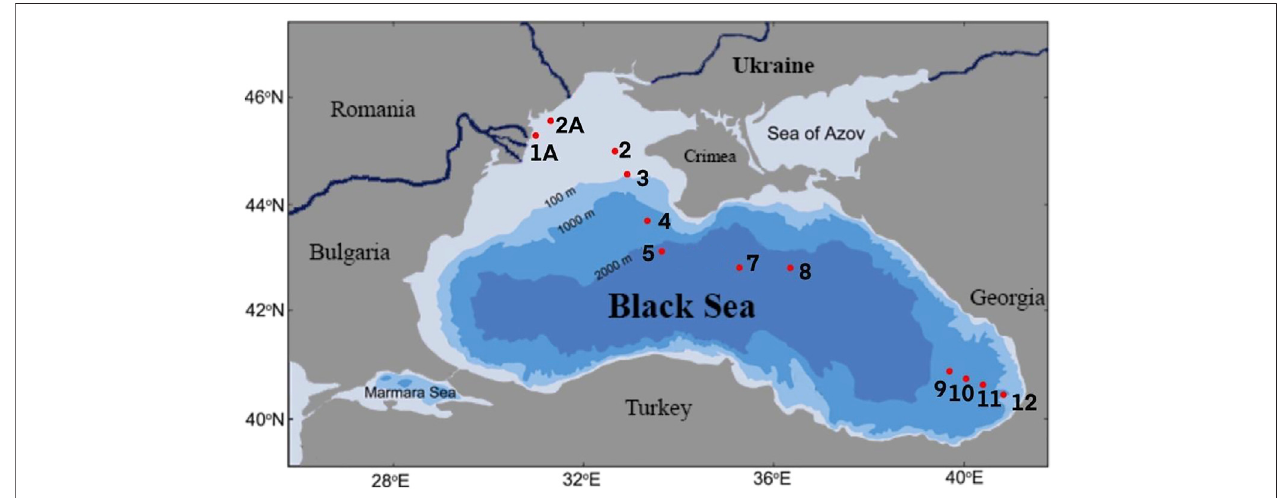
FIGURE 1 | Locations of the sampling